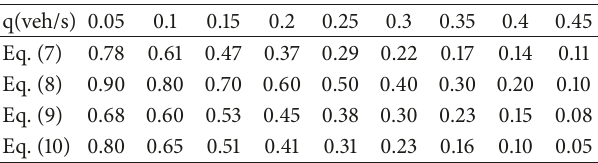
Table 2: The ratio of free flow using different equation under different flow rates on circulating vehicles.